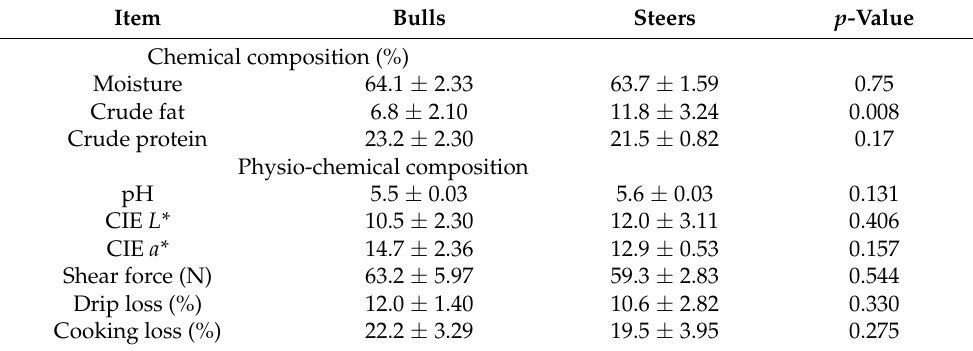
Table 3. Effect of early castration on chemical and physio-chemical compositions of the Holstein